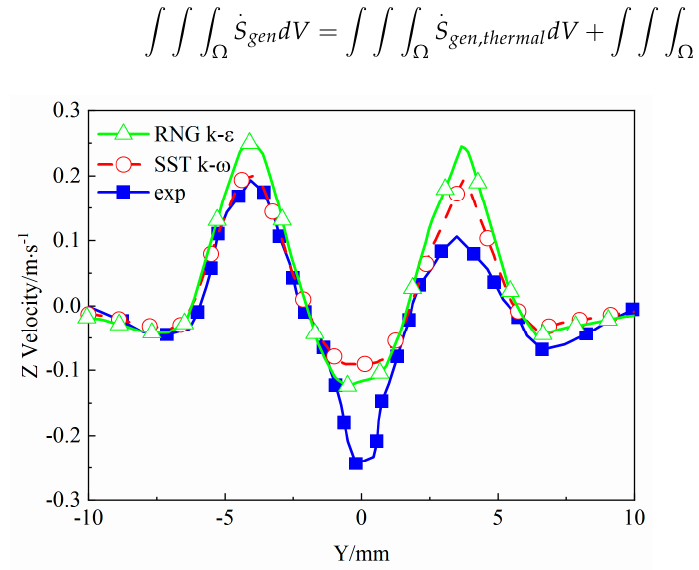
Figure 5. Numerical simulation and experimental [33] verification of DSJ underwater ( z = 2 mm).